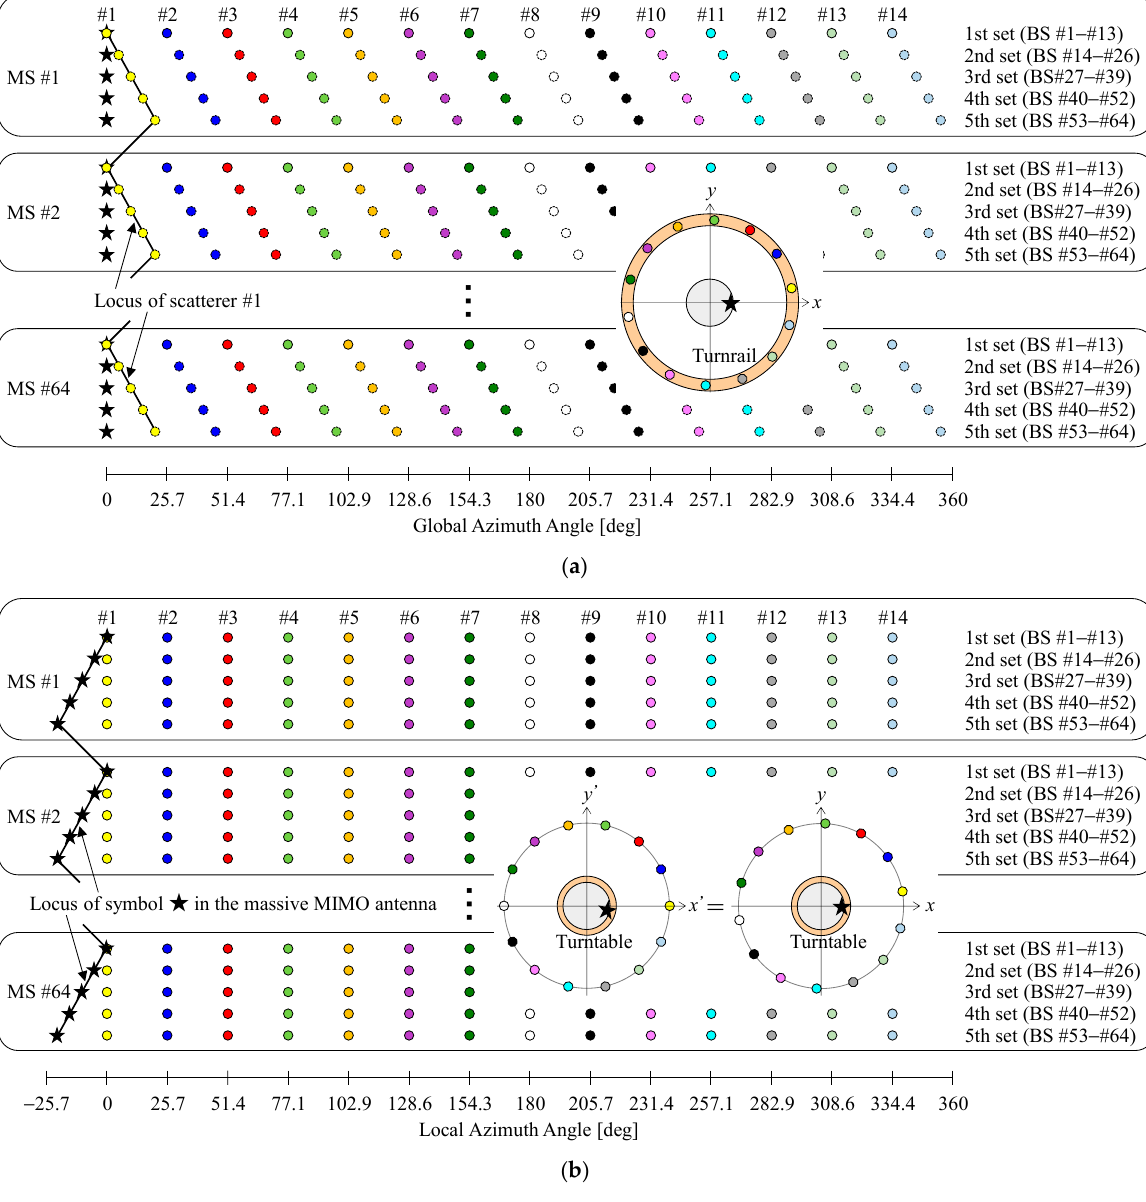
Figure 2. Massive MIMO OTA apparatus: ( a ) with the turn rail; ( b ) with the turntable.